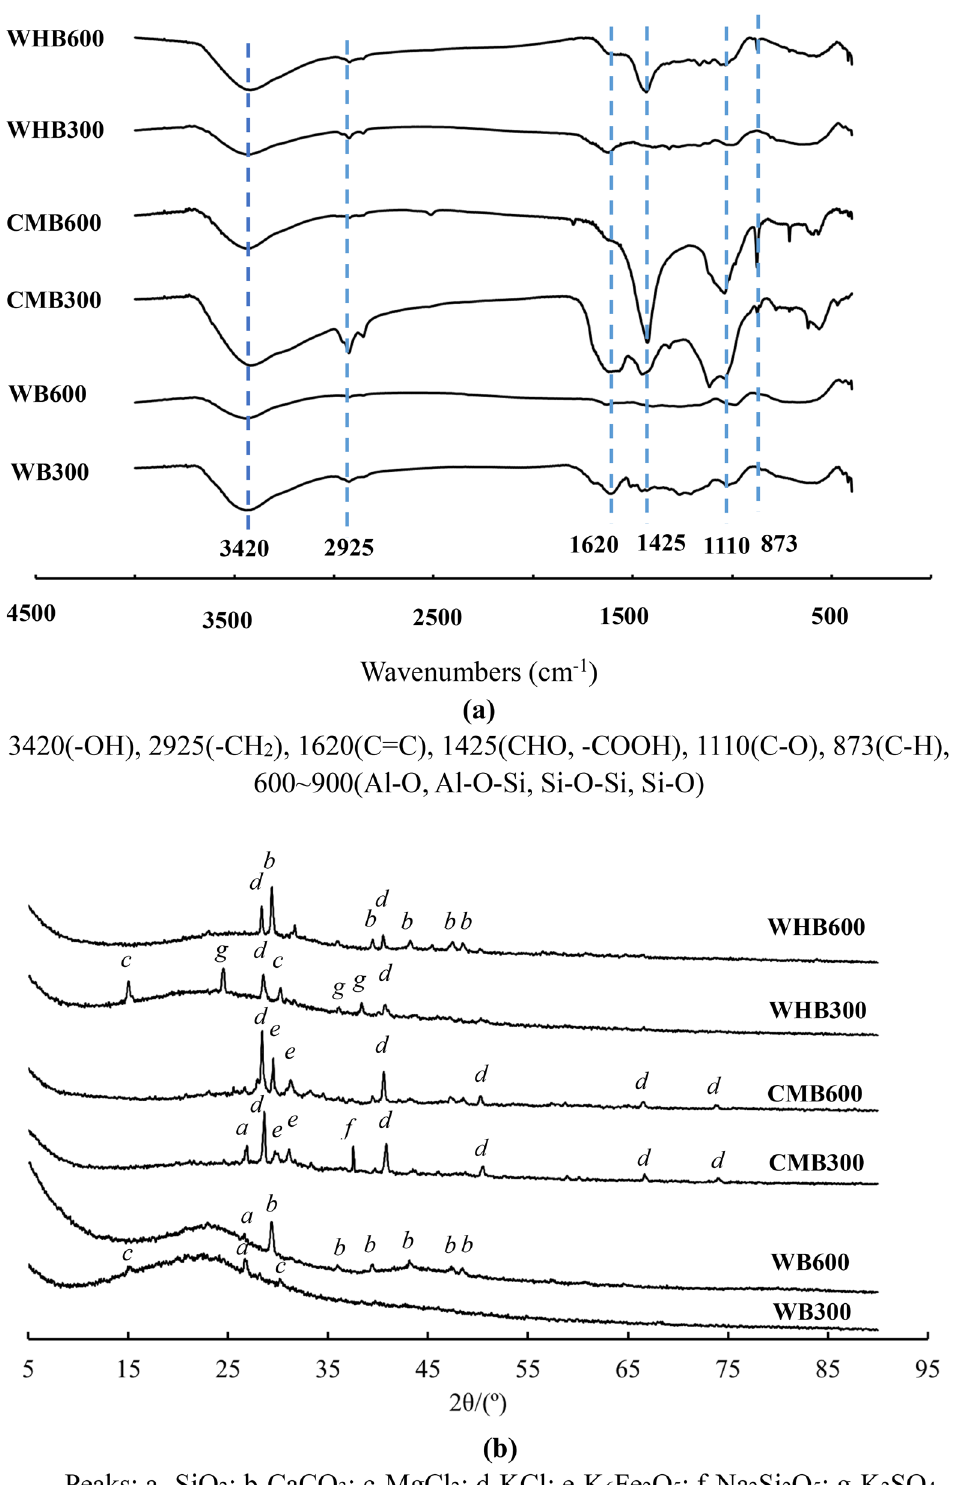
Figure 3. ( a ) FTIR analysis of biochar samples. ( b ) XRD analysis of biochar